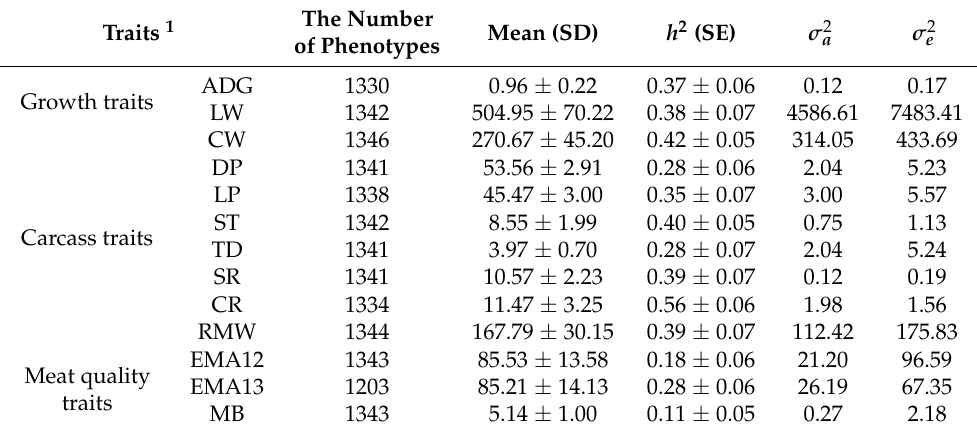
Table 1. Statistics and estimated heritability for studied traits in Chinese Simmental beef cattle.